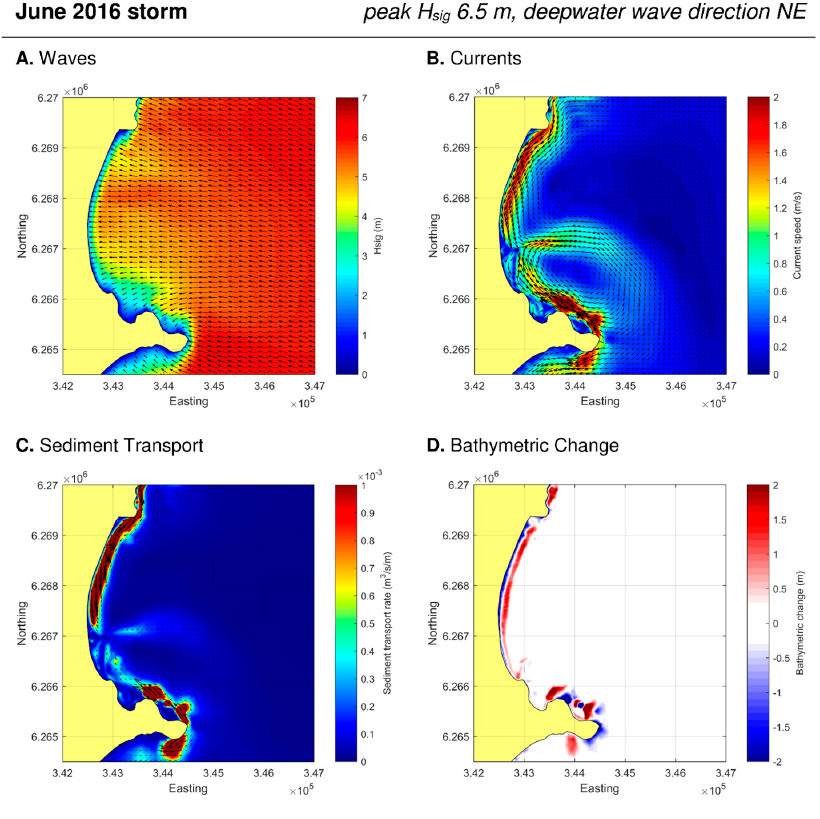
Figure 10. As for Figure 9 but for the June 2016 storm event.